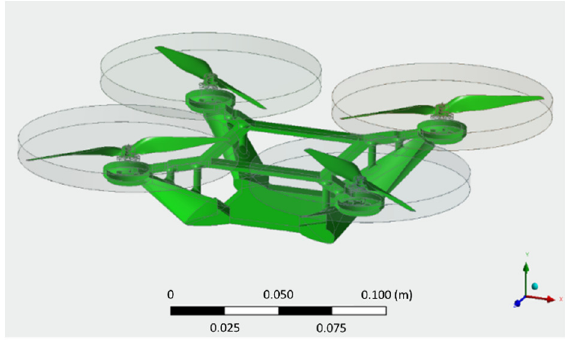
Figure 24. Quadcopter with Moving Reference Frame (MRF).